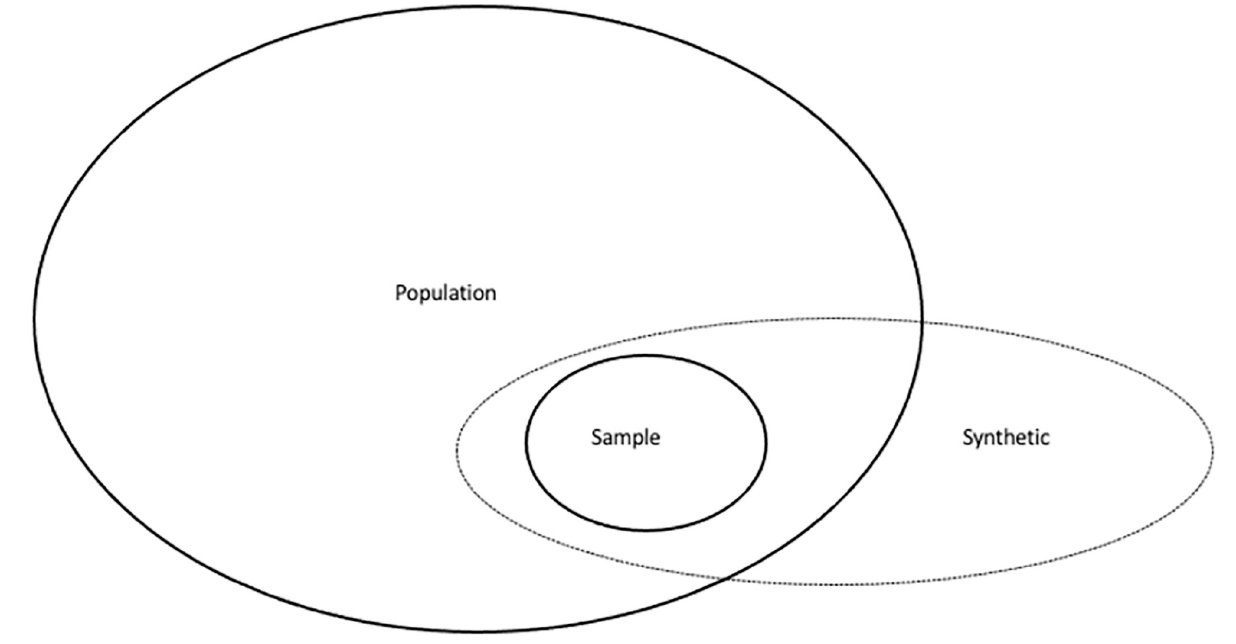
Fig 1. Relationship between population, sample and synthetic data